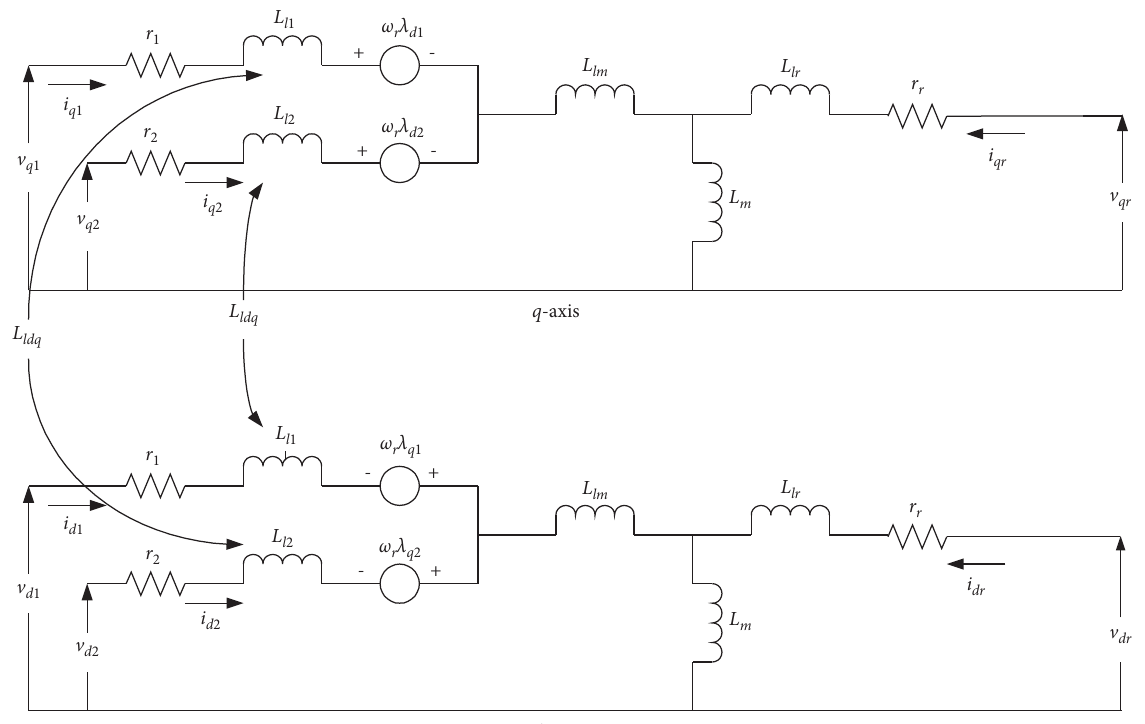
Figure 3: Equivalent circuit representation of an asymmetrical six-phase induction